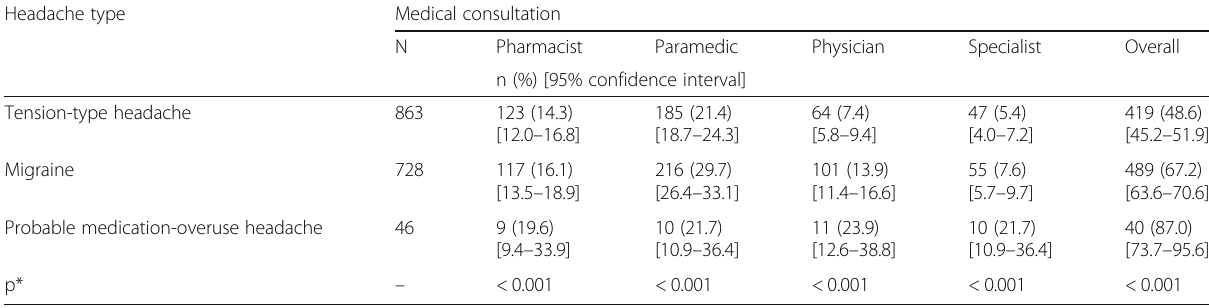
Table 1 Medical consultation according to class of professional health-care provider, by headache